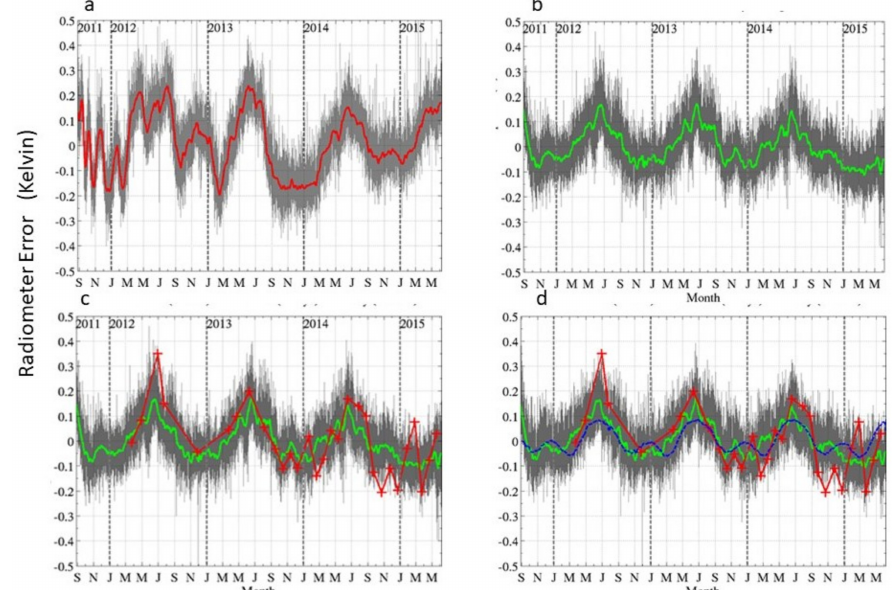
Figure 7. Radiometer residual error, TA—TA_exp, after removing the exponential drift ( a ) and then correcting for the radiometer backend instability ( b – d ). The data is for the Aquarius outer beam and horizontal polarization. Grey is the difference per orbit, and green is a seven-day average. Red in ( c , d ) shows the residual when looking at cold sky superimposed on the data in ( b ) (with a shift of 0.05 to align the curves). Crosses “+” indicate the data points. Blue in ( d ) shows the temperature of correlated noise diode centered on